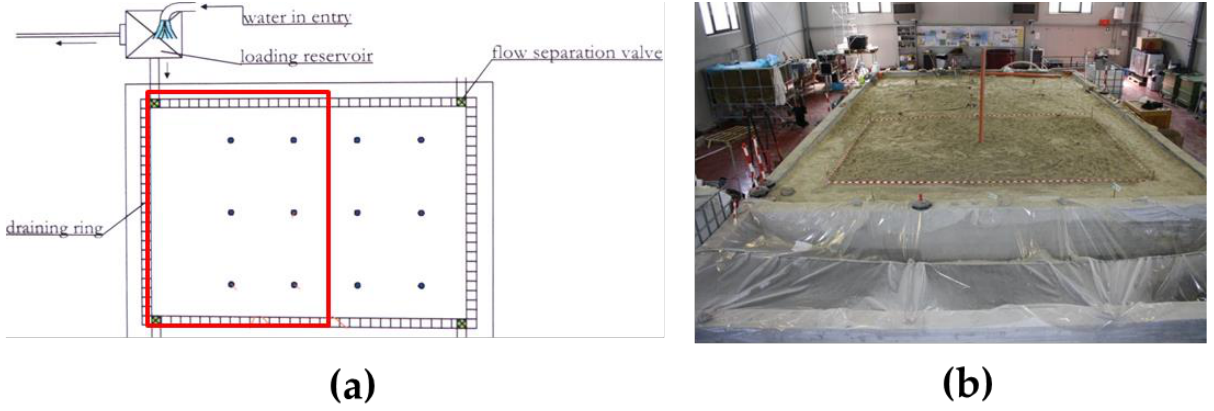
Figure 1. The operating system of the concrete pool used for hydrogeophysical experiments at the